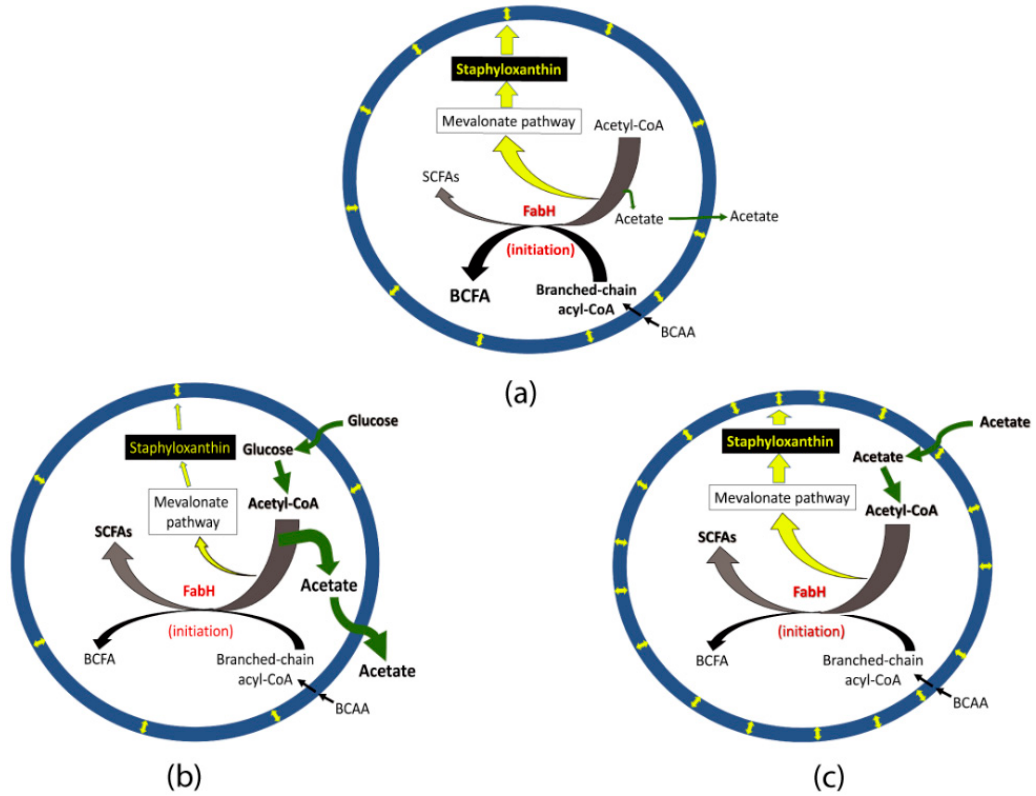
Figure 7. Proposed model on alterations in fatty acid composition and staphyloxanthin in S. aureus . Upper model ( a ) shows that higher proportion of BCFAs is achieved with higher affinity of FabH (initiation of fatty acid biosynthesis) for branched-chain acyl-CoA leaving abundant amounts of acetyl-CoA that can overflow towards staphyloxanthin production when S. aureus grown in glucose-lacking media such as LB or MHB. Lower left model ( b ) shows that glucose-supplementation in the growth medium causes production of excess acetyl-CoA molecules that are mostly converted into acetate and secreted outside. Note that the continuous supply of acetyl-CoA may favor an increased proportion of SCSFAs compared to cells grown without glucose-supplementation; Lower right model ( c ) shows that acetate-supplementation increases acetyl-CoA pool in the cytoplasm and, thus, increased the production of staphyloxanthin and SCSFAs. BCAA, branched-chain amino acids (valine, leucine, isoleucine). Note that acetyl-CoA is also used to make malonyl-CoA to be used in fatty acid elongation. The elongation process is the same for both SCSFA and BCFA synthesis utilizing malonyl-CoA biosynthesized from acetyl-CoA. The yellow double-arrowheads represent staphyloxanthin molecules in the membrane (thick blue circles).